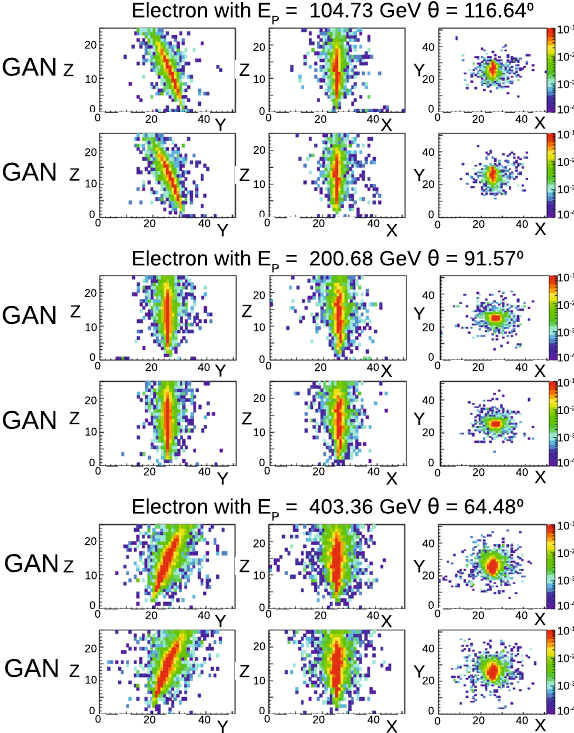
Fig. 12 Projections of random Mote Carlo events vs. the closet GAN event among the 2000 events generated for the same E P and θ . (Top) Fig. 13 Most similar pairs of electron events among the 2000 events E P = 101 . 63 GeV and θ = 115 . 58 ◦ . (Mid) E P = 196 . 4 GeV and generated by GAN for the same E P and θ . Projections on the YZ, XZ θ = 92 . 17 ◦ . (Bottom) E = 402 . 68 GeV and θ = 63 . 32 ◦ P and XY planes. (Top) E P = 104 . 73 GeV and θ = 116 . 64 ◦ . (Mid)